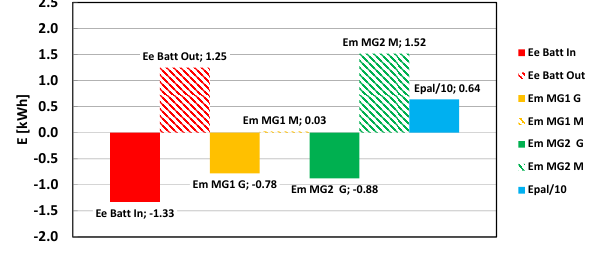
Fig. 1. Energy distribution in the hybrid drive system in the city part (City) of the RDE test (Toyota Yaris 1.5 Hybrid Dynamic Force e-CVT)